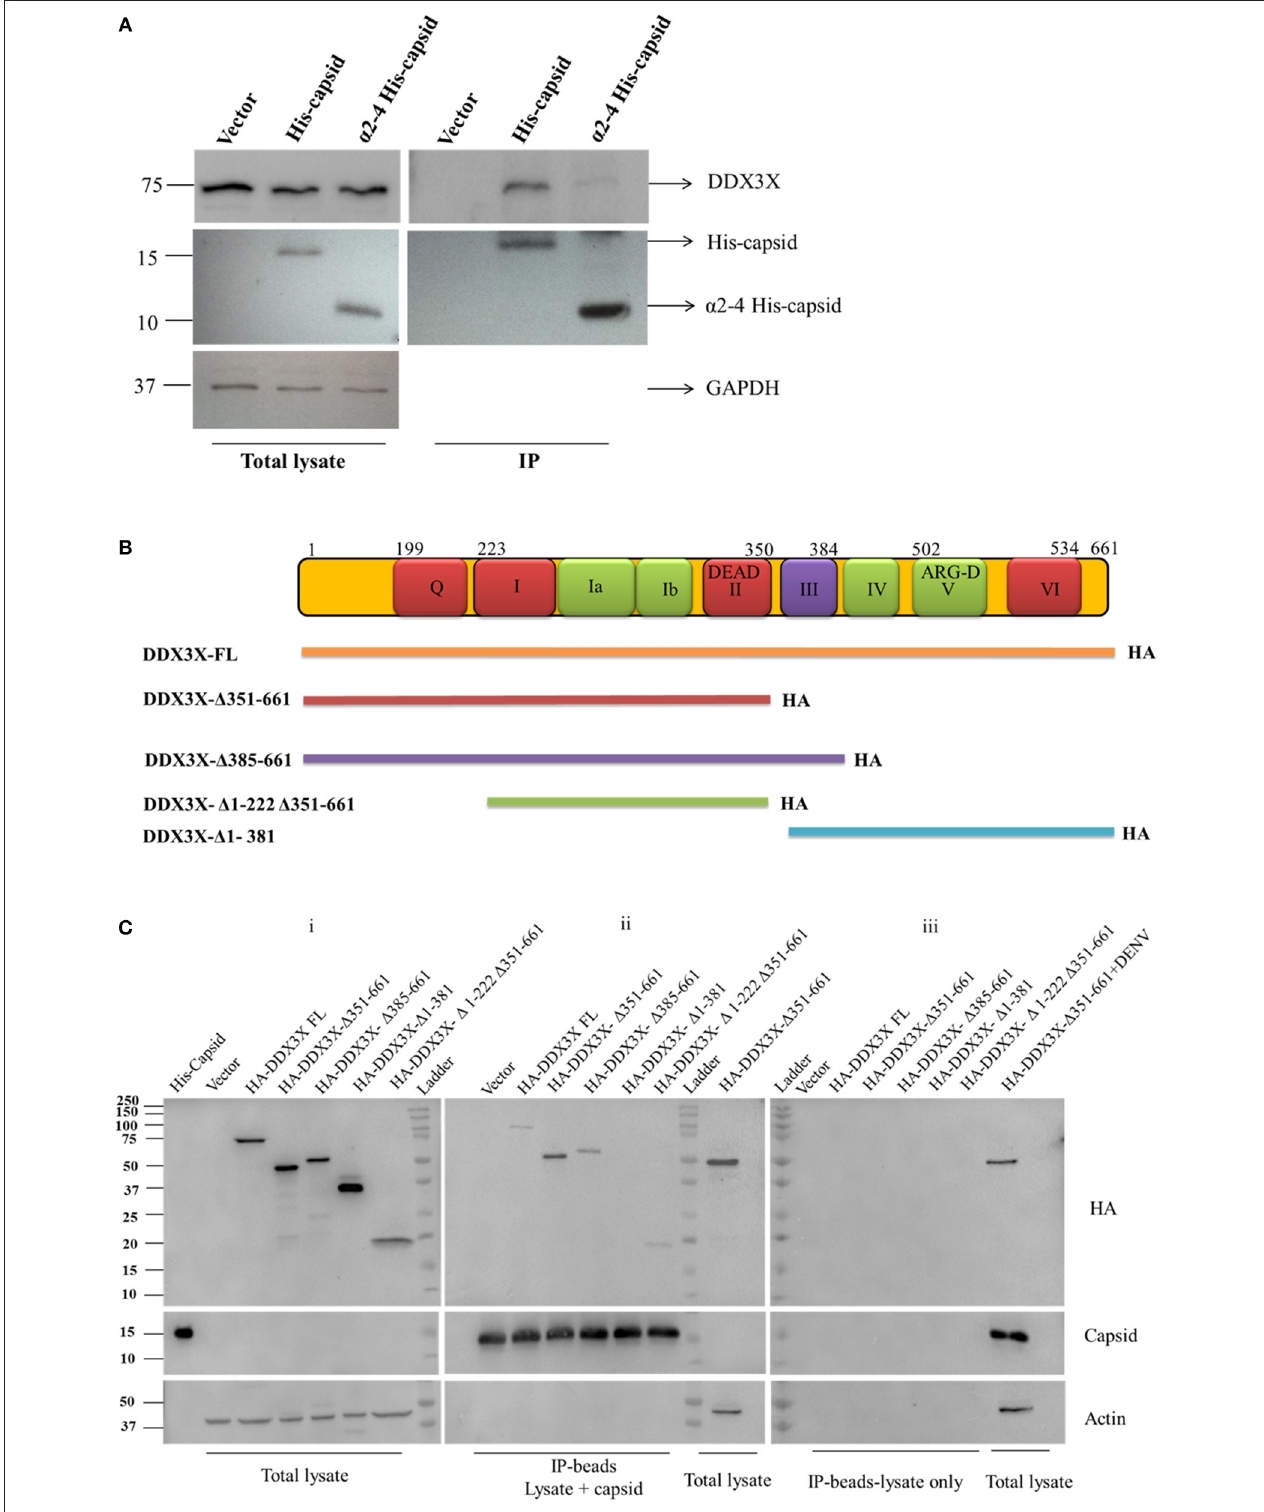
FIGURE 2 | Co-immunoprecipitation and pull-down of recombinant capsid and DDX3X. (A) Full length His-capsid and α 2-4 His-capsid were transfected in HEK293T cells and lysates were prepared 24h p.t. Lysates were used for IP with capsid antibody and blots were probed for capsid, DDX3X and GAPDH. (B) Map of